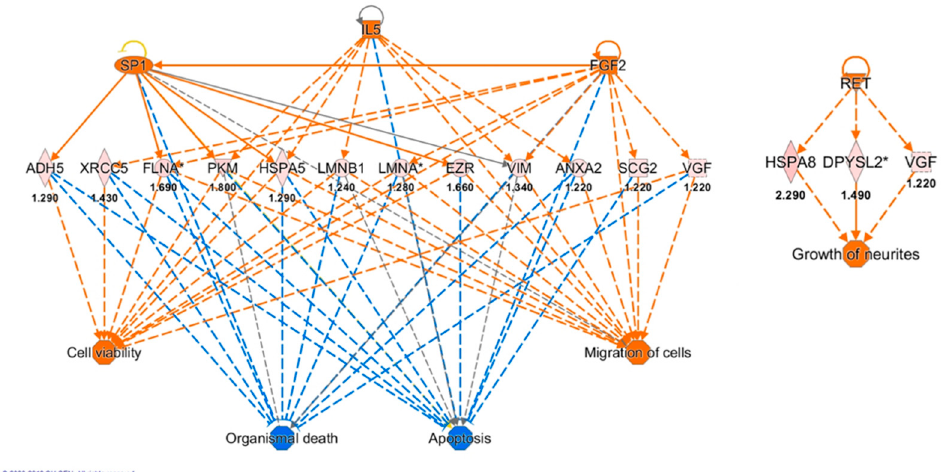
Figure 7. Regulator network generated by IPA. Upstream regulators (SP1, IL5, FGF2 and RET) are displayed in the top tier while functions are displayed in the bottom tier. The data set proteins connecting regulators and lower functions are shown in the middle tier where the fold change value of each protein expression is reported below the gene name. The predicted regulators had a z-score (activation score) > 1.9 and a Fisher’s exact p -value < 0.05. Dashed lines are indirect effects and the protein shape indicates the protein class (defined by IPA). Orange and cyan connecting lines indicate activation and inhibition, respectively. Similarly, activated and inhibited downstream functions are orange and cyan. * More than one spot was identified for this protein.